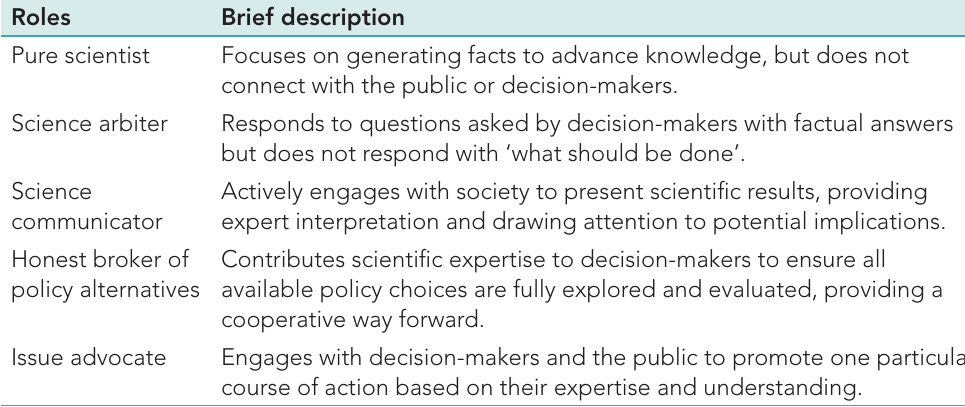
Table 1: Brief descriptions of the professional roles scientists can adopt throughout their careers